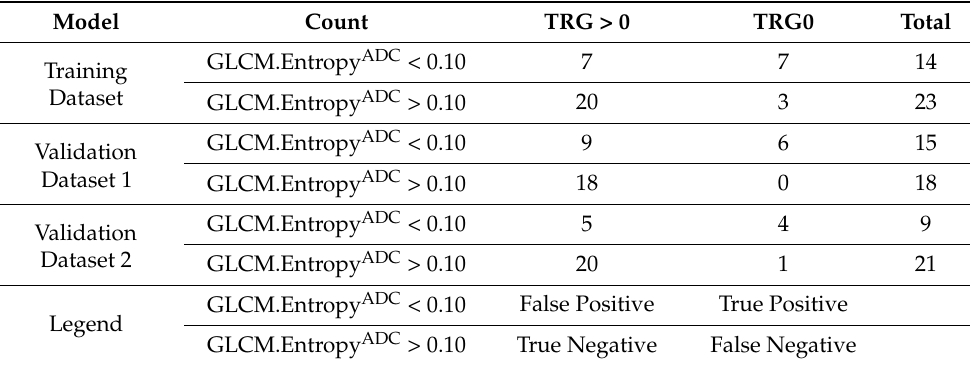
Table 4. Specificity, sensibility, and accuracy of the cut-off of the texture parameter GLCM. Entropy ADC